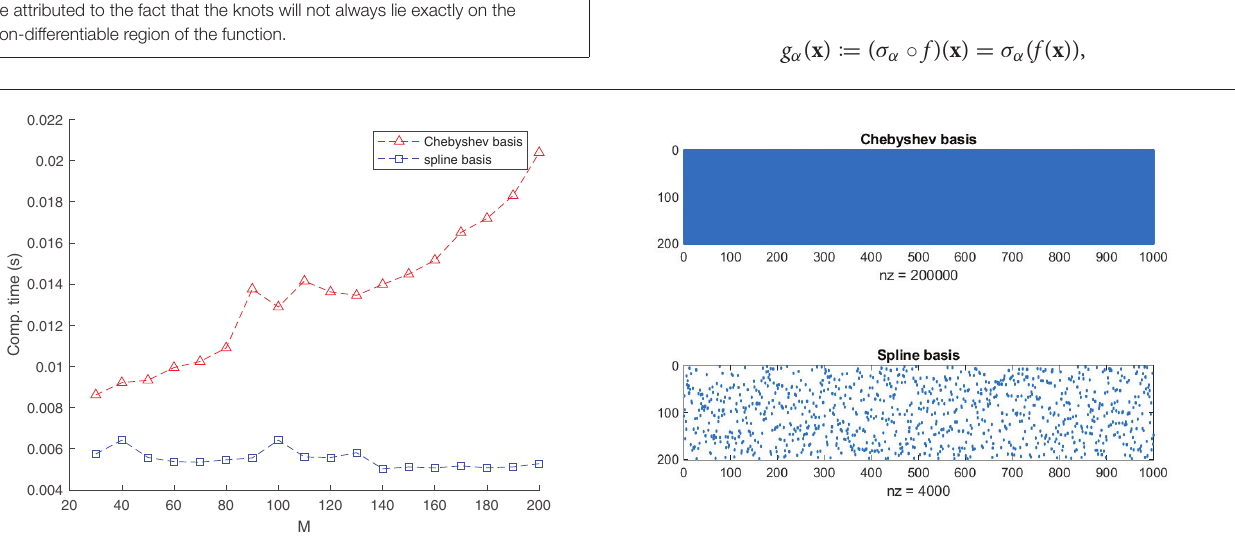
FIGURE 5 | The exploitation of the sparsity in the B-spline basis matrix A ( d ) : the average required computation time to pass through one cycle of the GN algorithm for a B-spline basis of order N random data points to fit the function (Equation 19). The rank is set to R d . This sparsity is exploited in the implementation. In the case of the Chebyshev basis, there is no sparsity pattern to be exploited.